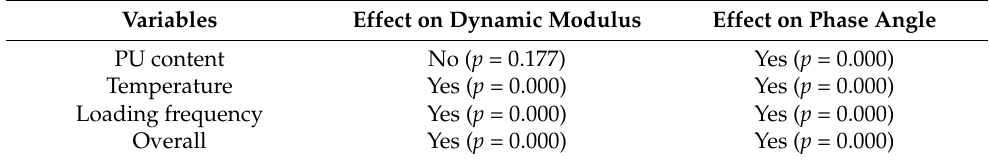
Table 7. Statistically significant effect of the PU content in the dynamic modulus and phase